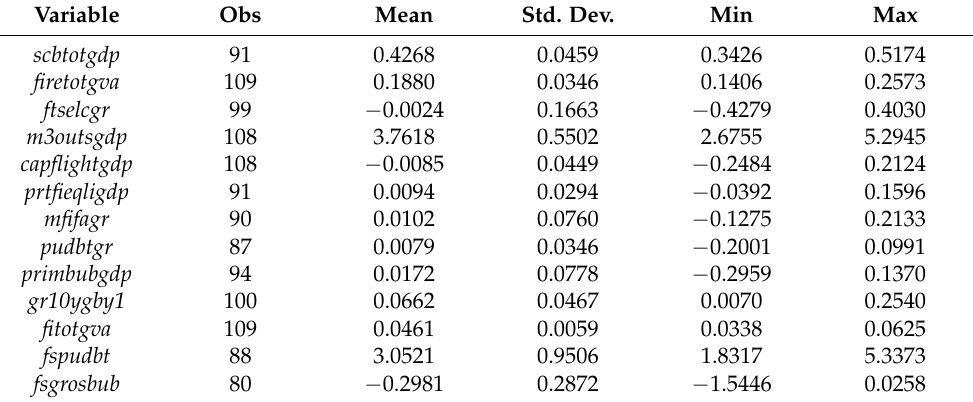
Table 1. Descriptive Statistics.